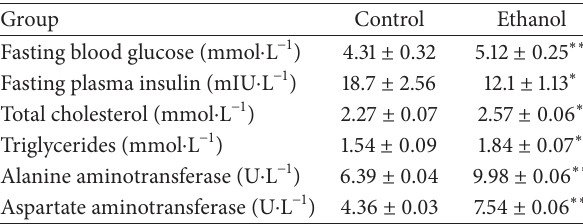
Table 2: Metabolic parameters of ethanol and control rats.